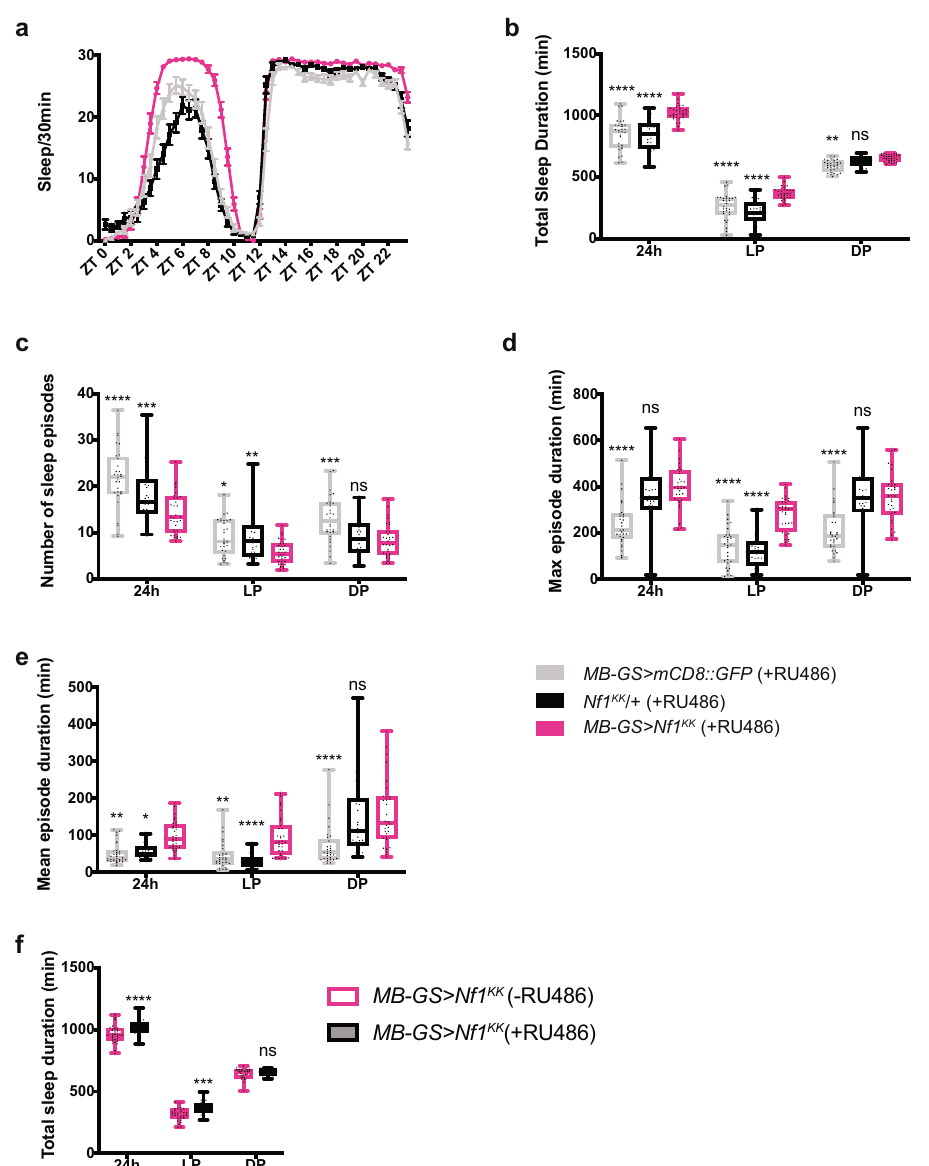
Fig. 5 NF1 in adult MB promotes daytime wakefulness. a Sleep pro fi les of MB-GS > NF1 KK , MB-GS > mCD8::GFP , and Nf1 KK / + fed with RU486 after eclosion to selectively induce MB-GS activity during adulthood. Sleep per 30 min bin averaged over 5 days of LD in the presence of RU486 is shown ( n = 29 – 32 per group). Data are represented as mean values ± SEM. b – e Different sleep variables analyzed over 24 h, during the light phase (LP) and the dark phase (DP). The center lines of the boxplots indicate the median, box boundaries are 25th and 75th percentiles, and the whiskers represent the minimum and maximum values. Values of MB-GS > NF1 KK were compared with those of the two controls by two-way ANOVA with Dunnett ’ s correction for multiple comparisons (* p < 0.05, ** p < 0.01, *** p < 0.001, and **** p < 0.0001). b Total sleep duration. c Number of sleep episodes. d Maximum sleep episode duration. e Mean sleep episode duration. f Total sleep duration of the MB-GS > NF1 KK fl ies fed with RU486 ( + RU486) or those without RU486 ( − RU486). n = 32 for + RU486 and n = 32 for -RU486. Two-way ANOVA with Dunnett ’ s correction for multiple comparisons found an increase in daytime sleep and sleep over a 24 h period following the induction of MB-GS with RU486 (*** p < 0.001 and **** p < 0.0001). Source data are provided as a Source Data fi